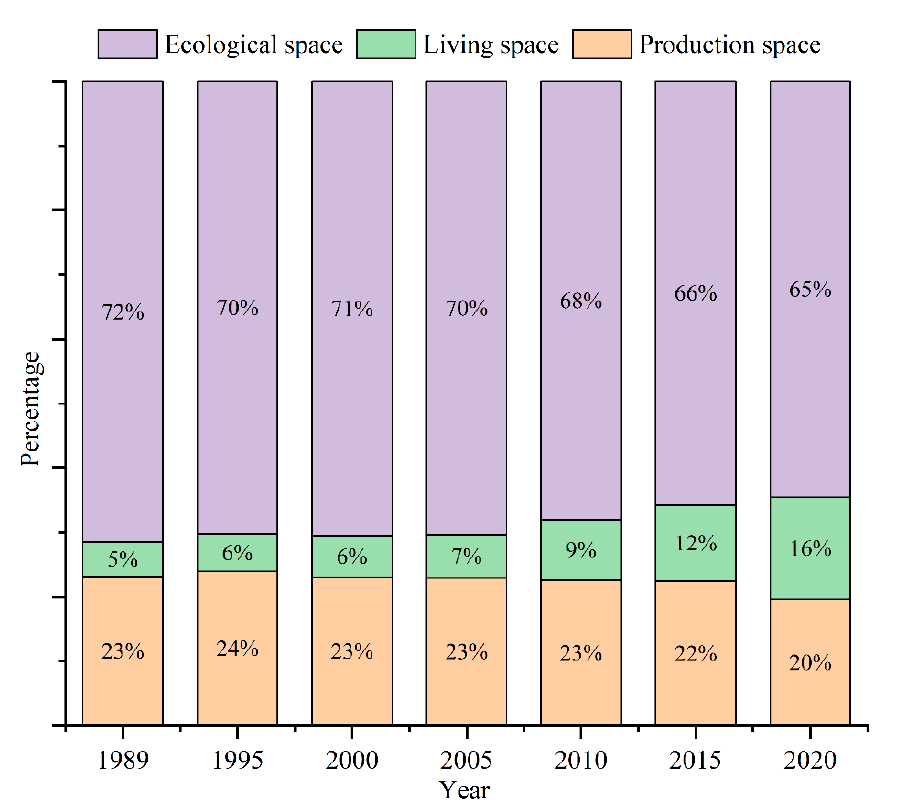
Figure 4. Area percentage of PLE space from 1989 to 2020.